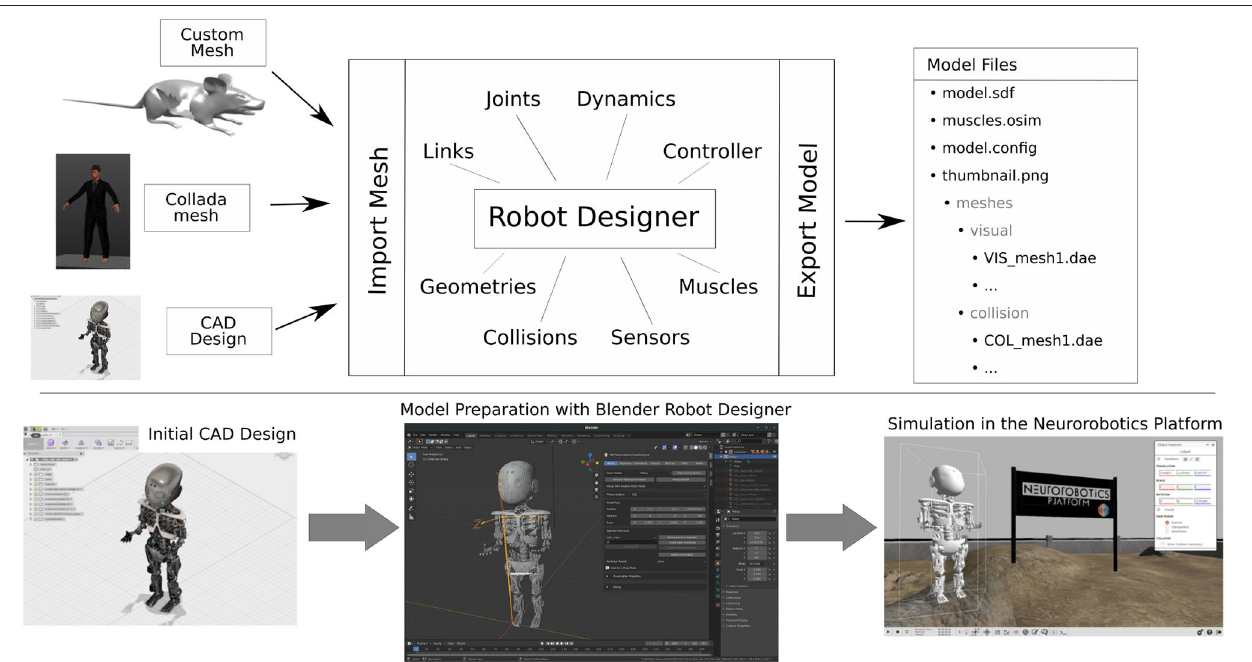
FIGURE 3 | Robot Designer Workflow: The user can create a new model either by designing custom meshes from scratch or by importing an existing geometry, e.g., from CAD software. With the Robot Designer, all specifications relevant for robots and musculoskeletal models can be added and modified, ranging from kinematics, dynamics and geometries to sensors and muscles. Finally, the model description files are exported. The bottom part visualizes an exemplary workflow from CAD design via model preparation with the Robot Designer in Blender and finally its simulation in the Neurorobotics